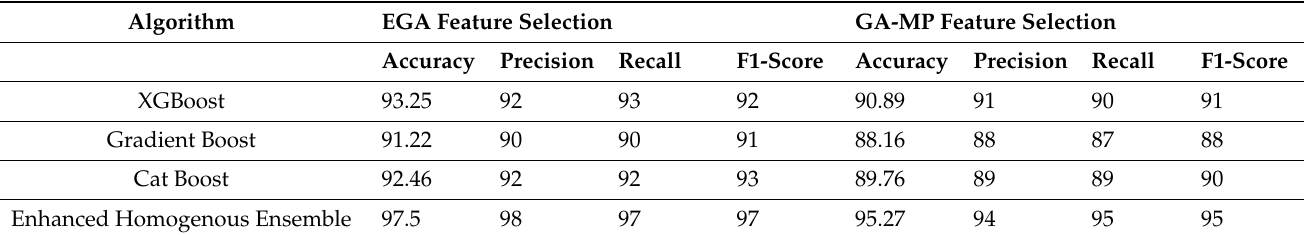
Table 5. Evaluation performance of classifiers algorithms models after EGA feature selection.